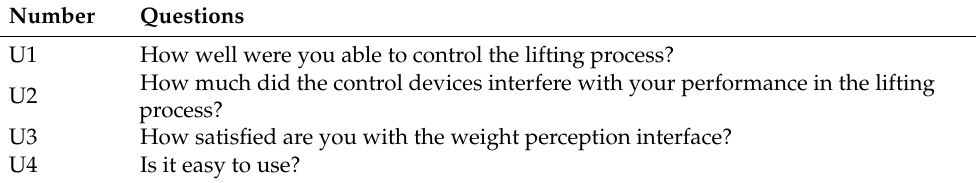
Table 4. Questionnaire on usability of weight perception